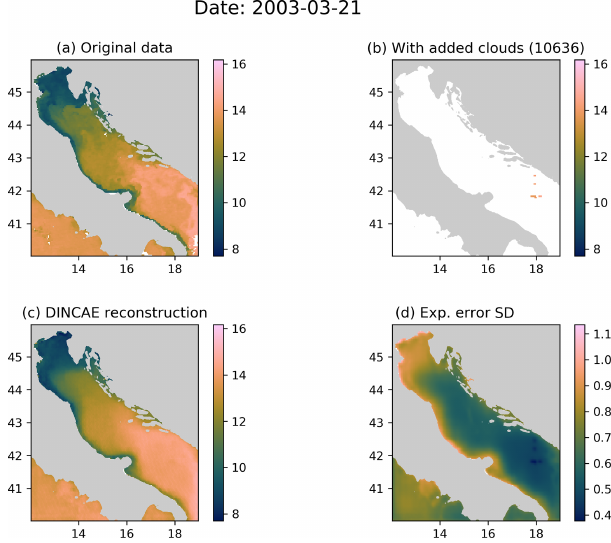
Figure 3. (a) The original MODIS SST; (b) MODIS SST with ad- ditional clouds for cross-validation; (c) the DINCAE reconstruction using the data from panel (b) ; (d) the expected error standard devi- ation of the DINCAE reconstruction. All panel values are in ◦